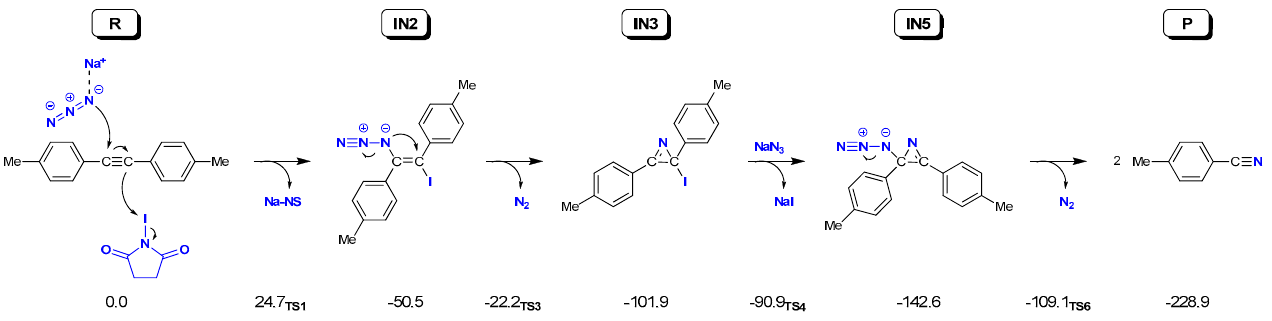
Figure 4. Reaction mechanism for the conversion of 2 with NIS and NaN 3 . Relative Gibbs free energies (in kcal mol − 1 ) correspond to the MeCN solution. TS and IN denote transition states and intermediates, while R and P stand for reactants and products. Graphical representation of the reaction profile is given as Figure S2.